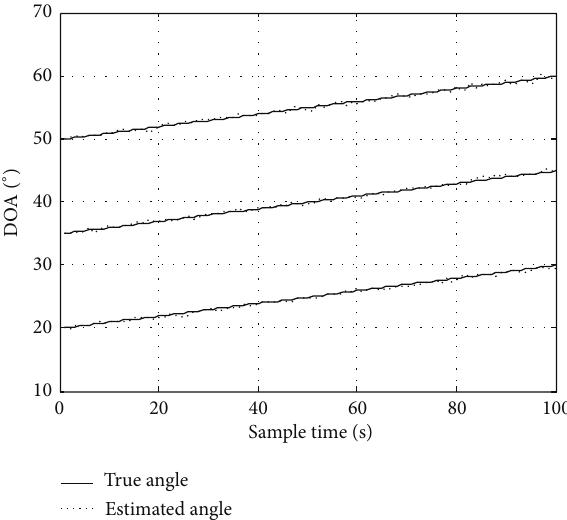
Figure 3: DOA tracking results of the proposed algorithm at SNR = 15 dB (Scene 1).